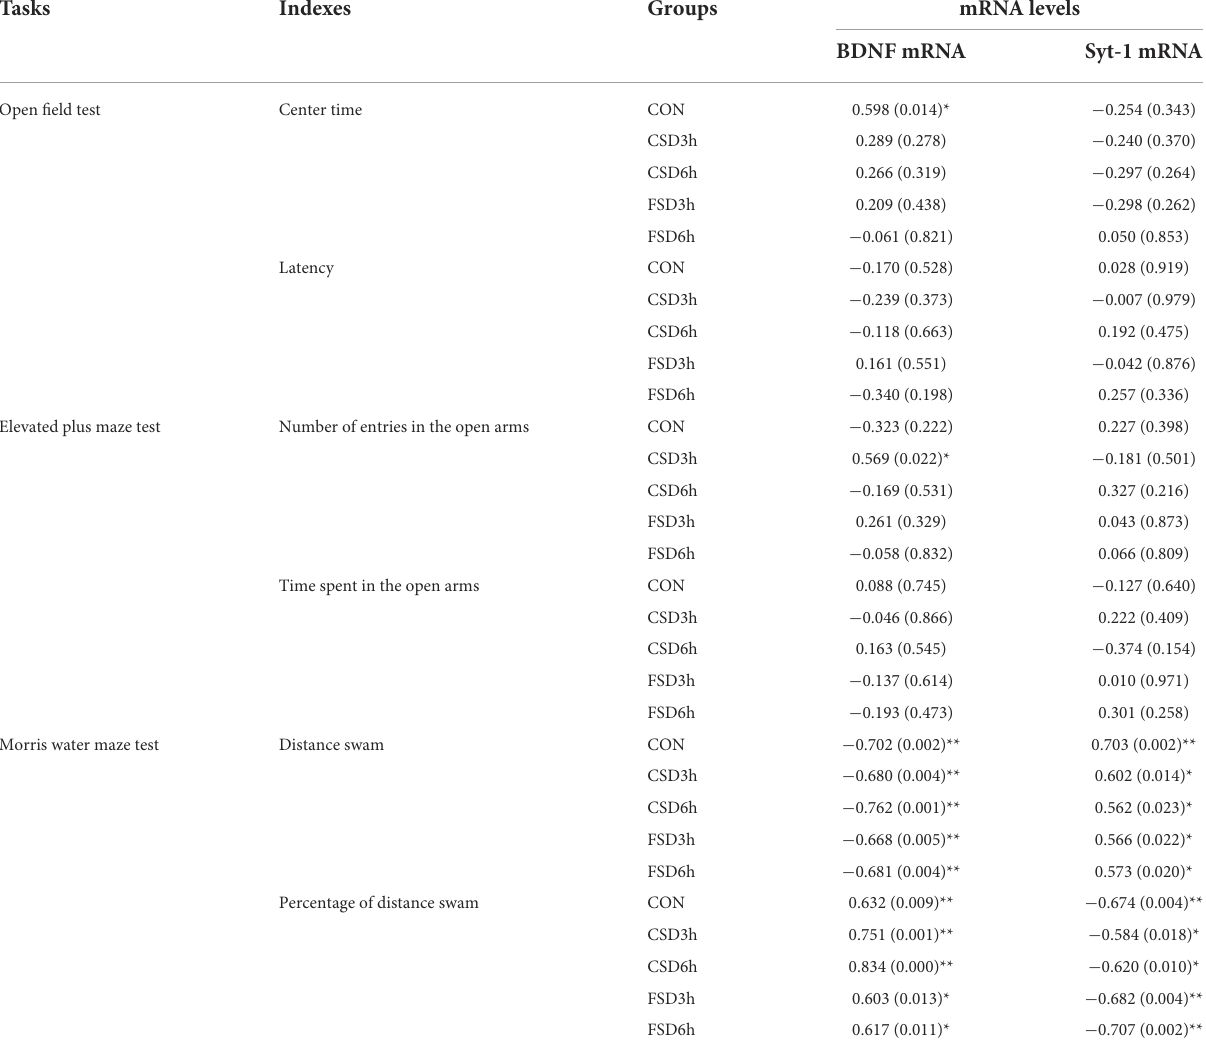
TABLE 3 Correlation between the performance in the anxiety/cognition-related tasks and hippocampal mRNA levels of BDNF and Syt-1 [ r ( p )].